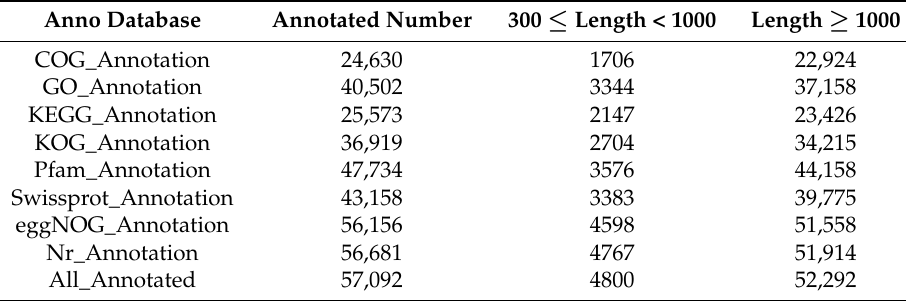
Figure 2. Characteristics of homology search of genes against the NR database. ( A ) Species distribution is shown as percentage of the total homologous gene hits. All of the top five species are Leguminosae. ( B ) E-value distribution of BLAST hits for each transcript with a cut-off of E-value of 1 × 10 − 5 . Table 2. Summary of database matches for the C. obtusifolia.